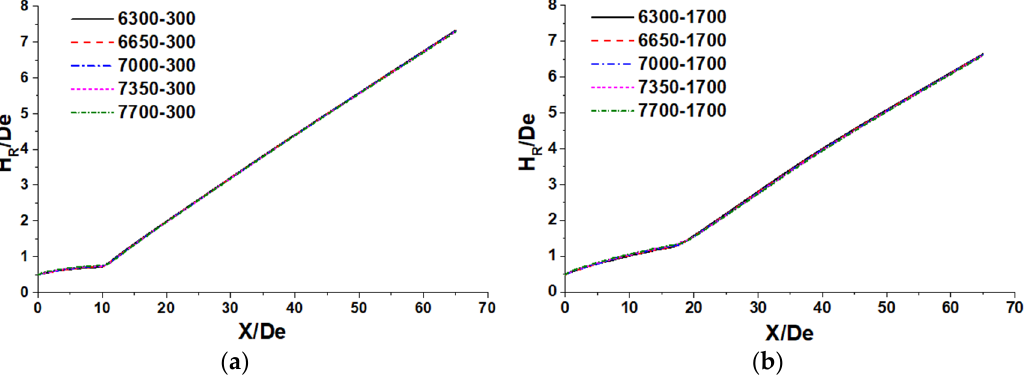
Figure 5. Half-jet radius distribution of supersonic jet with various N 2 flow rates: ( a ) room ambient temperature; ( b ) high ambient temperature. Table 3. The slopes of the A and B segments.